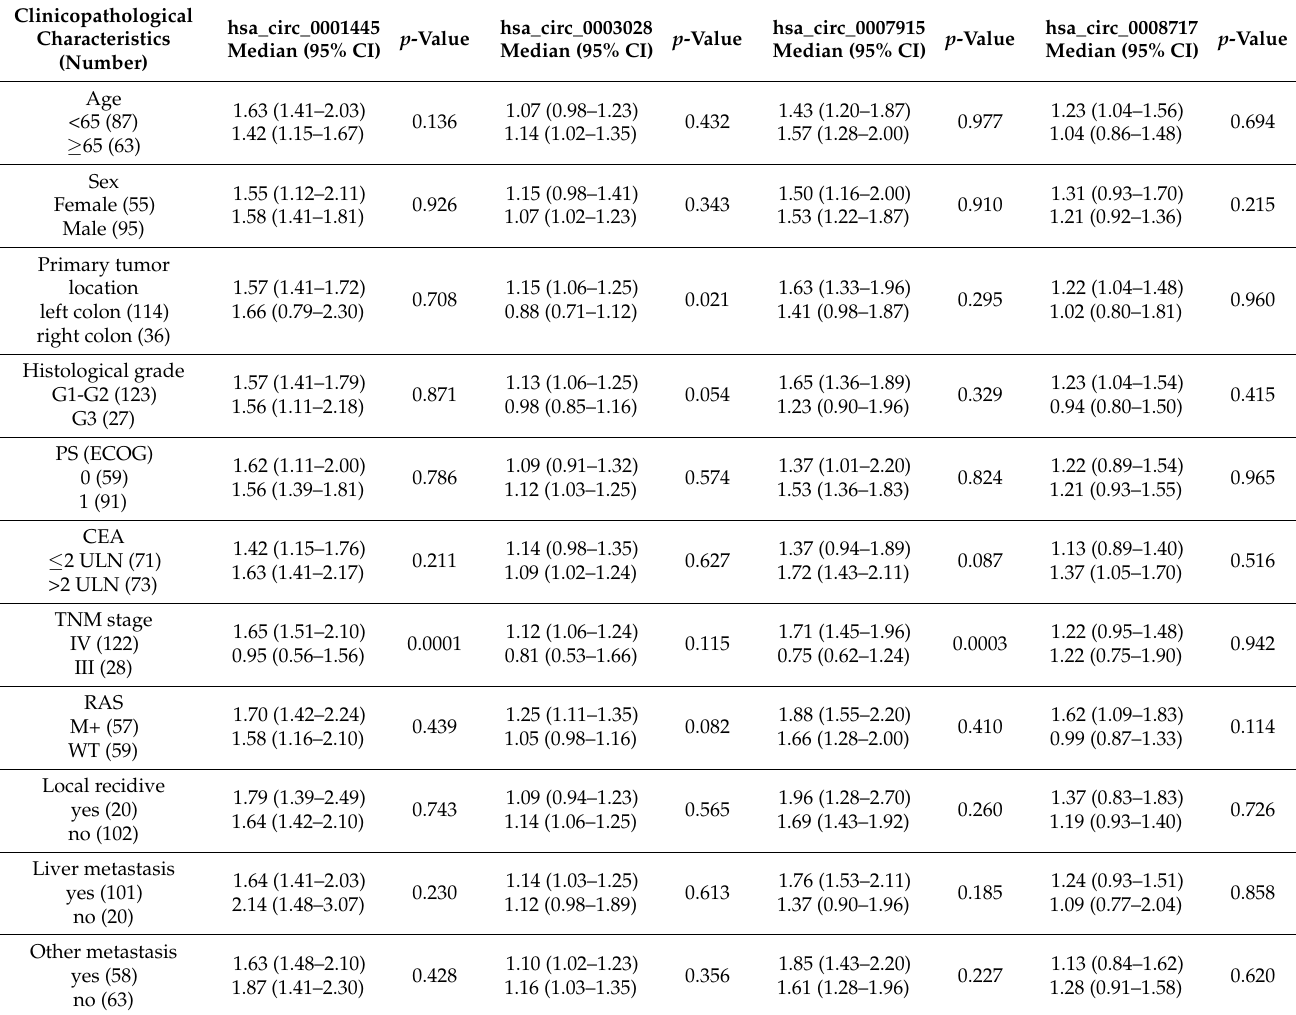
Table 2. circRNAs plasma expression and clinicopathological characteristics of the CRC